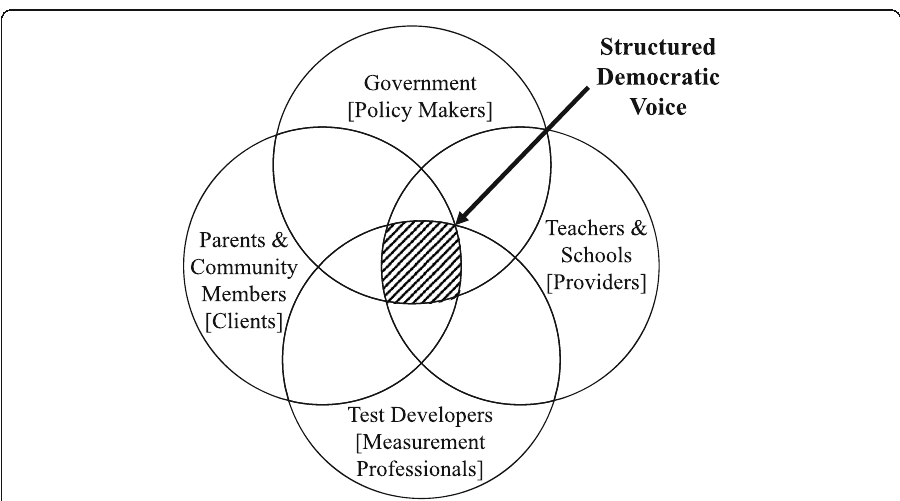
Fig. 4 Adapted from “ Improving accountability in education: The importance of structured democratic voice, ” W. C. Smith and A. Benavot, 2019, Asia Pacific Education Review, 20 , p. 202. CC BY